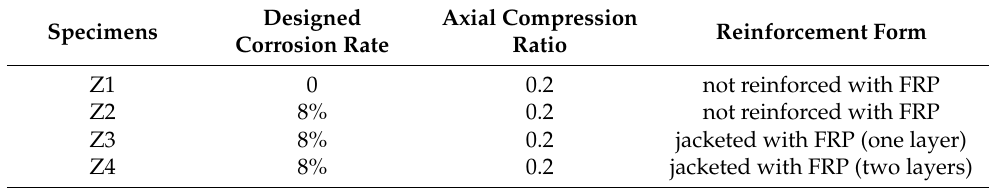
Table 1. Main parameters of hysteretic